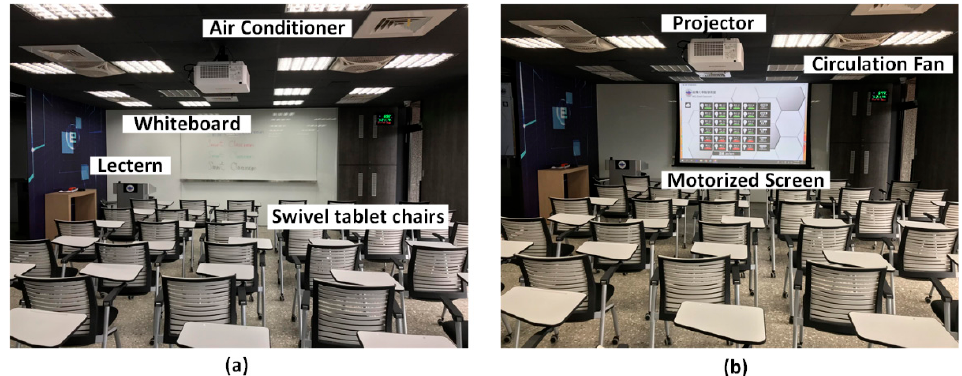
Figure 1. Basic requirements for a comfortable teaching and learning environment: Lights in di ff erent areas can be controlled respectively; ( a ) a whiteboard for traditional lecture. Chairs with wheels and a tablet for the convenience of notes taking, using a notebook computer, and group discussion, A lectern for teacher with a computer connected to a touch screen and the projector; ( b ) a projector Figure 2. Swivel tablet chairs for dynamic seat rearrangement: ( a ) seats can be adjusted dynamically with motorized screen for lecturing with digital contents. Circulation fans and air conditioner for to face toward different interactive boards and ( b ) round table with any amount of seats. a comfortable learning environment. Lights in di ff erent areas can be controlled respectively.